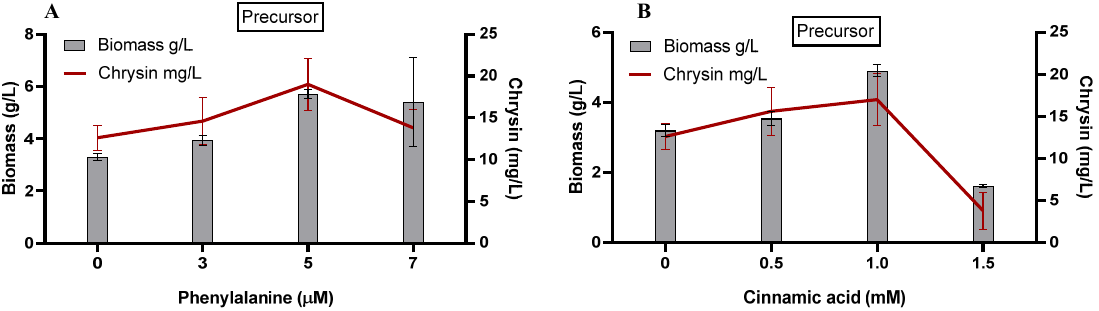
Figure 2. Effect of precursor feeding on C. globosum biomass and production of chrysin. Flavonoid